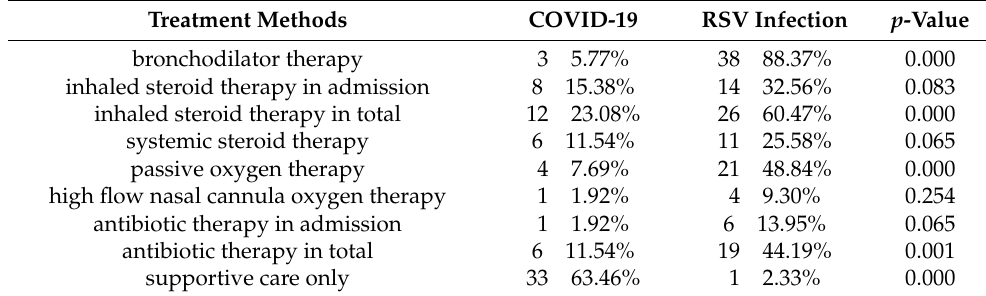
Table 3. Treatment methods used in patients with COVID-19 and RSV infection.